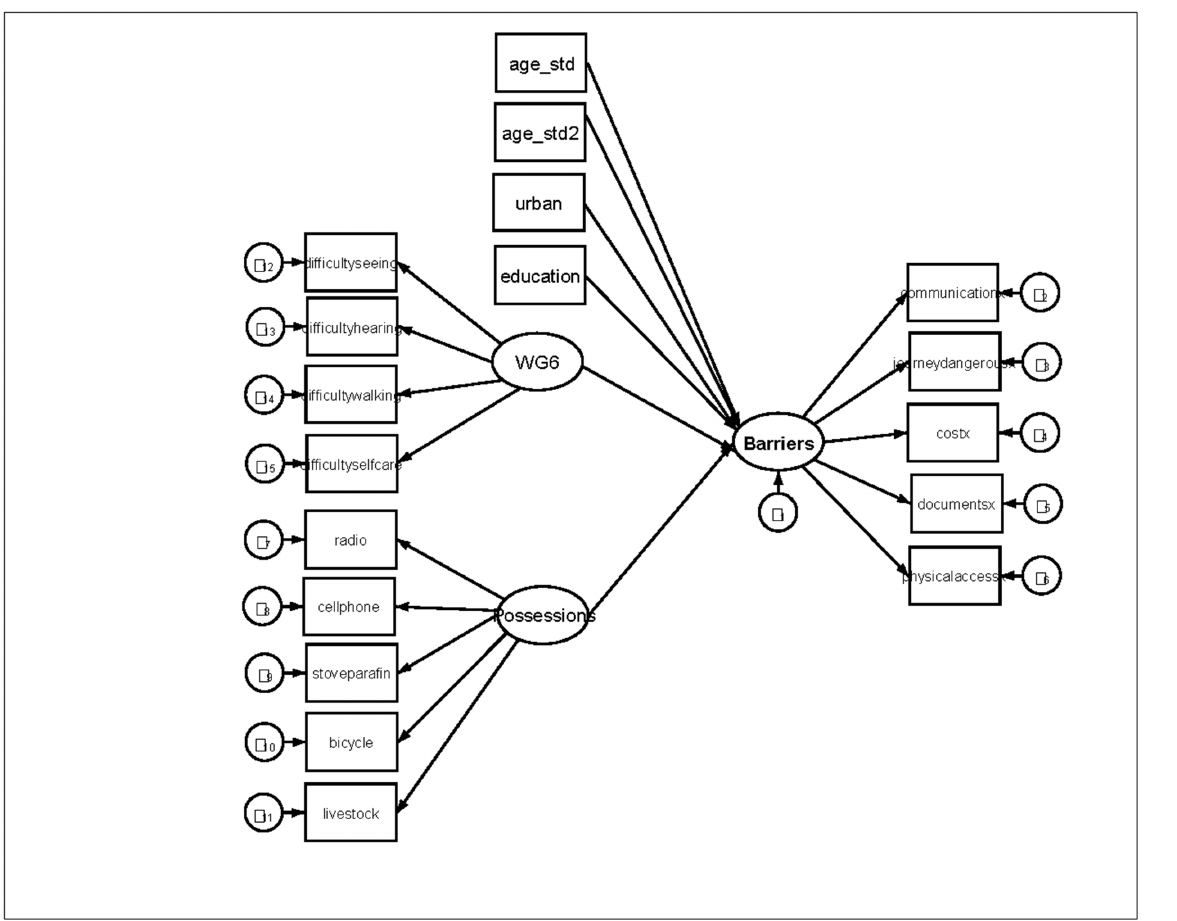
Fig 3. Structural equation